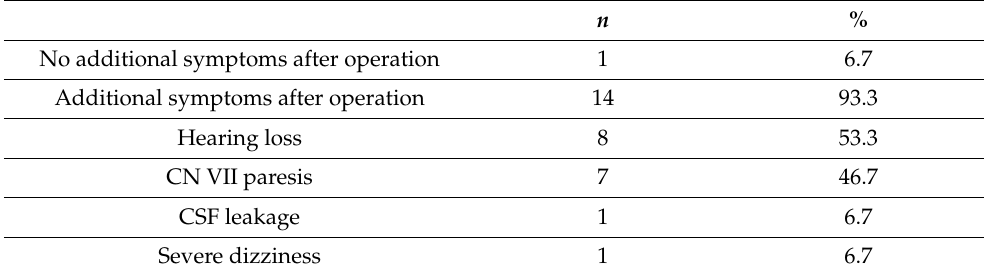
Table 2. Totally removed cerebellopontine angle lipomas ( n = 15) and outcomes. n % No additional symptoms after operation 1